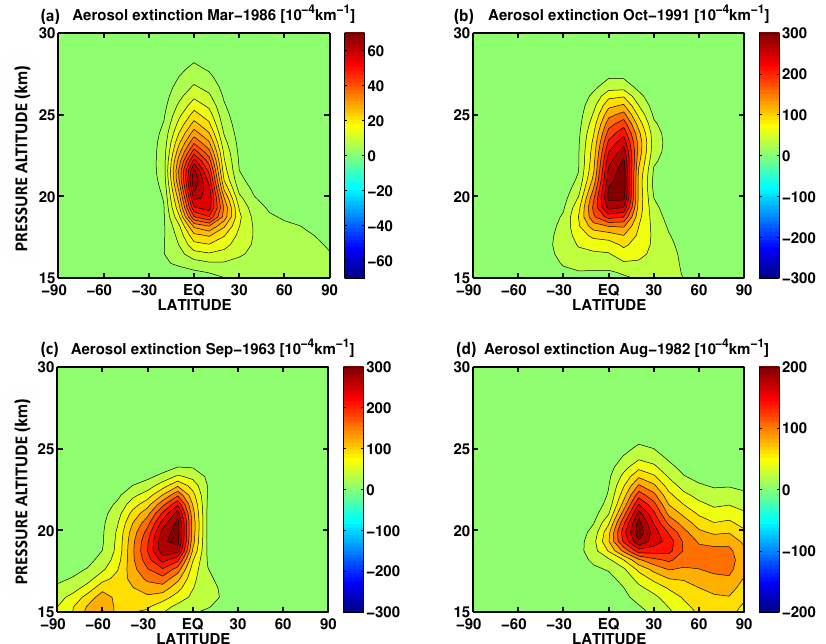
Figure 6. Top panels ( a,b ) show the ULAQ model prediction of zonally averaged aerosol extinction at λ = 0.55 µ m during the month of March 1986 ( a ) and October 1991 ( b ), following the major eruptions of Nevado del Ruiz ( a ) and Pinatubo ( b ) (E wind shear). Bottom panels (c ,d ) as in (a,b) but for September 1963 ( c ) and August 1982 ( d ), following the major eruptions of Agung ( c ) and El Chichón ( d ) (W wind shear). Only in March 1986 and October 1991 (E wind shear) is the aerosol extinction strongly confined around the equator with high values well above 24 km